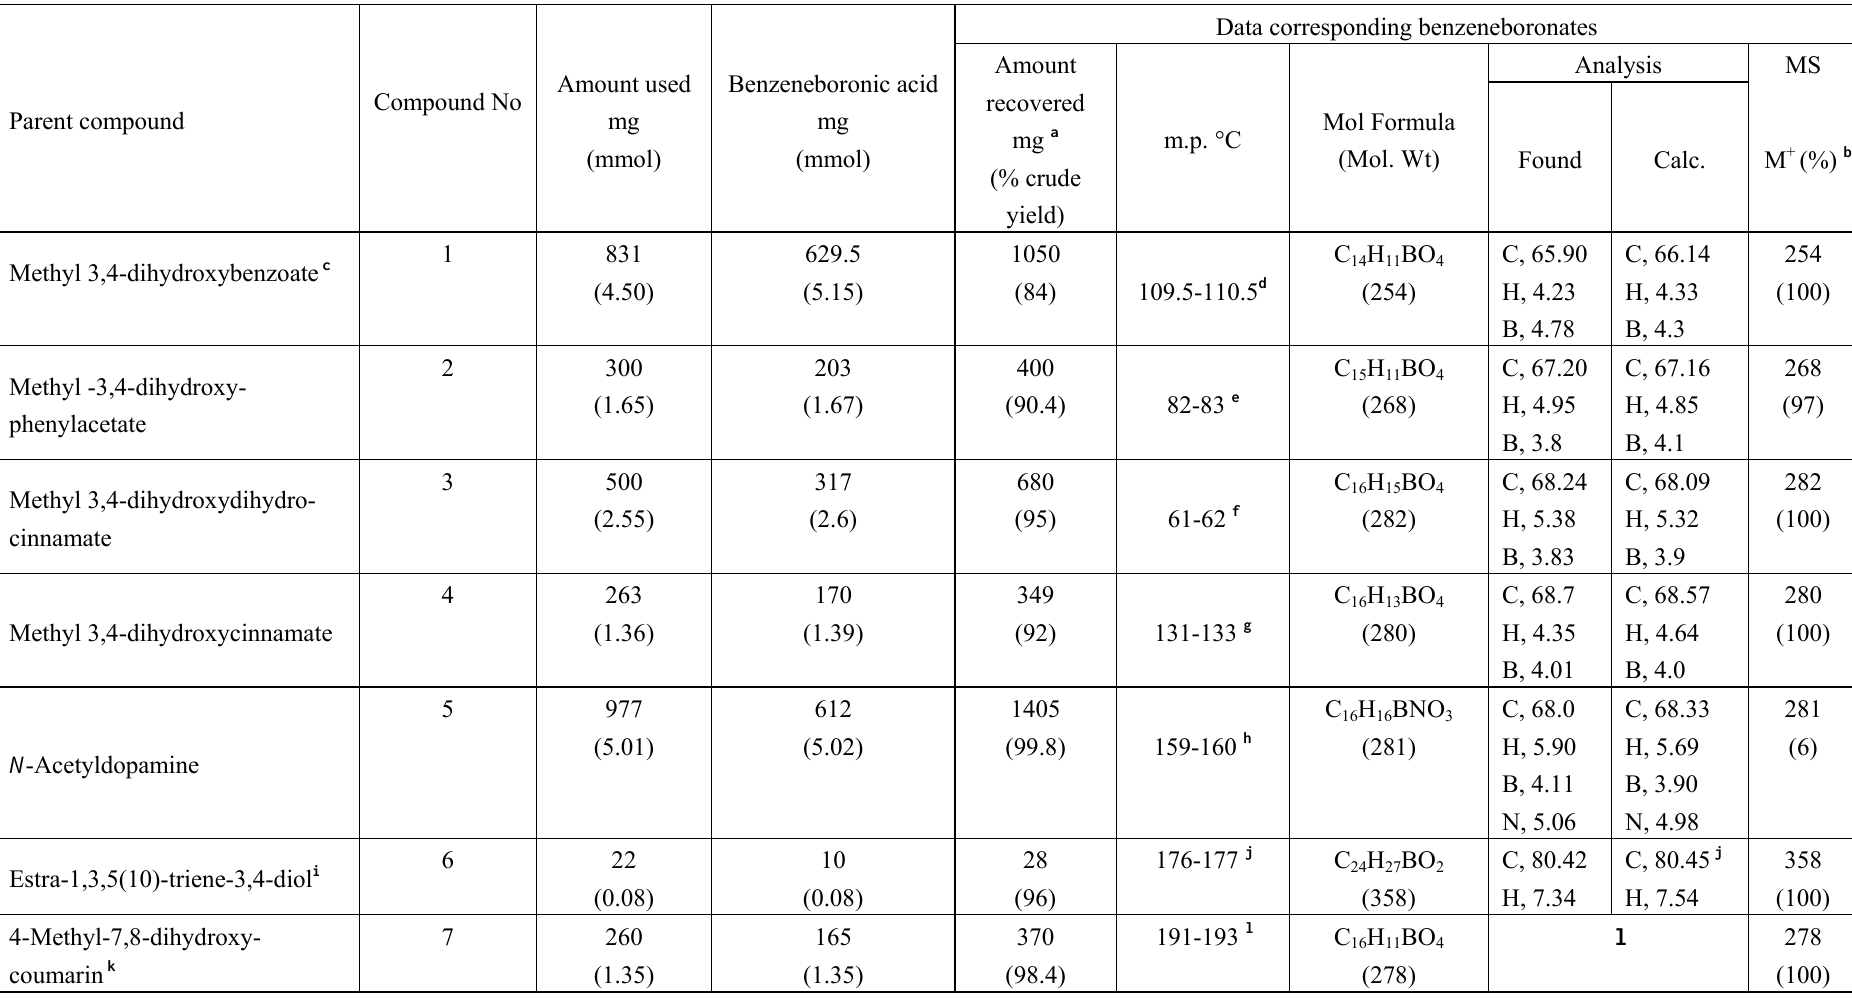
Table 1. Preparative benzeneboronate derivative formation from catechol type